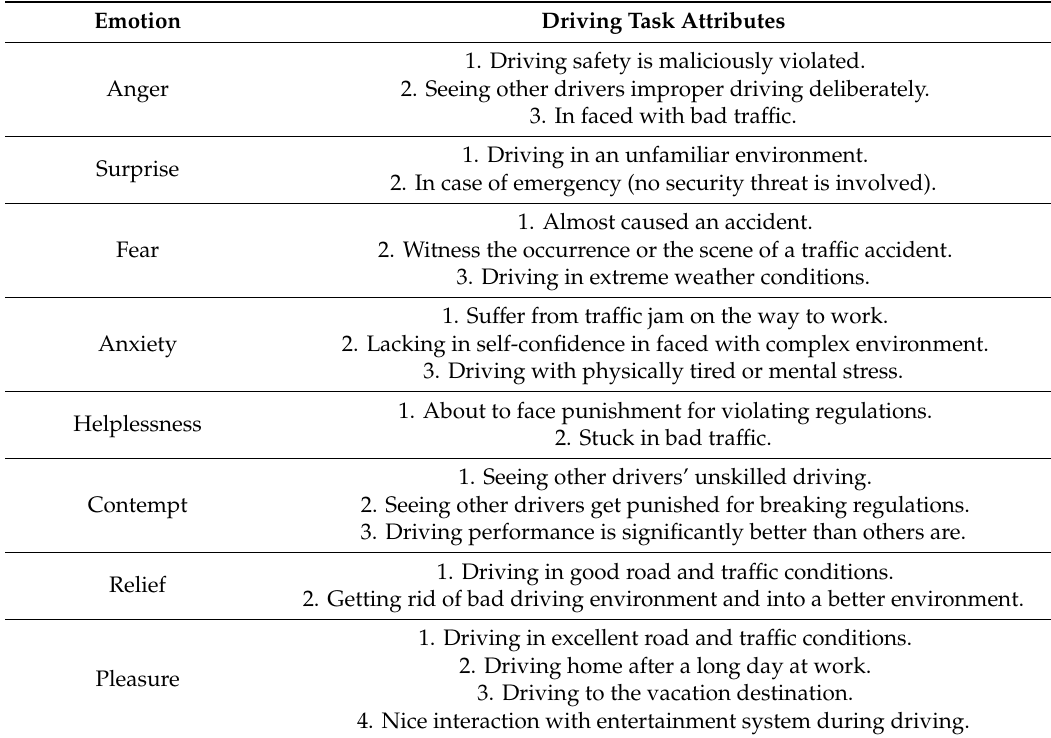
Table 7. Hypothetic driving task